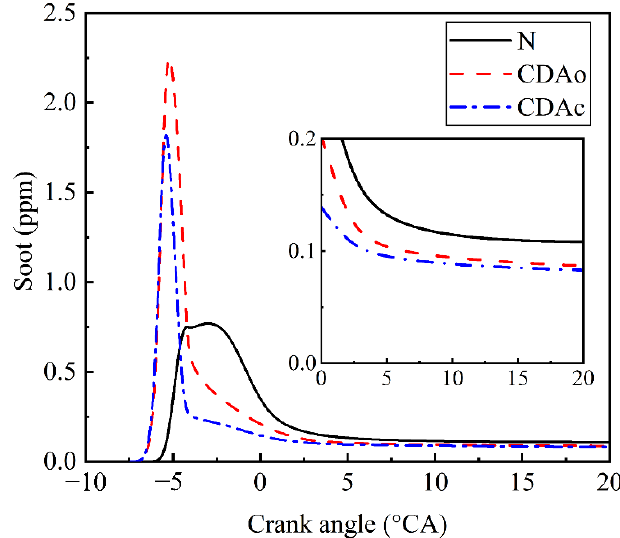
Figure 13. Comparison of soot formation in the active cylinder between the normal operation and two CDA modes at an engine speed of 450 rpm and an engine load of 1000 N ∙ m (the calculated results were obtained from 3D simulation of ESE DIESEL).